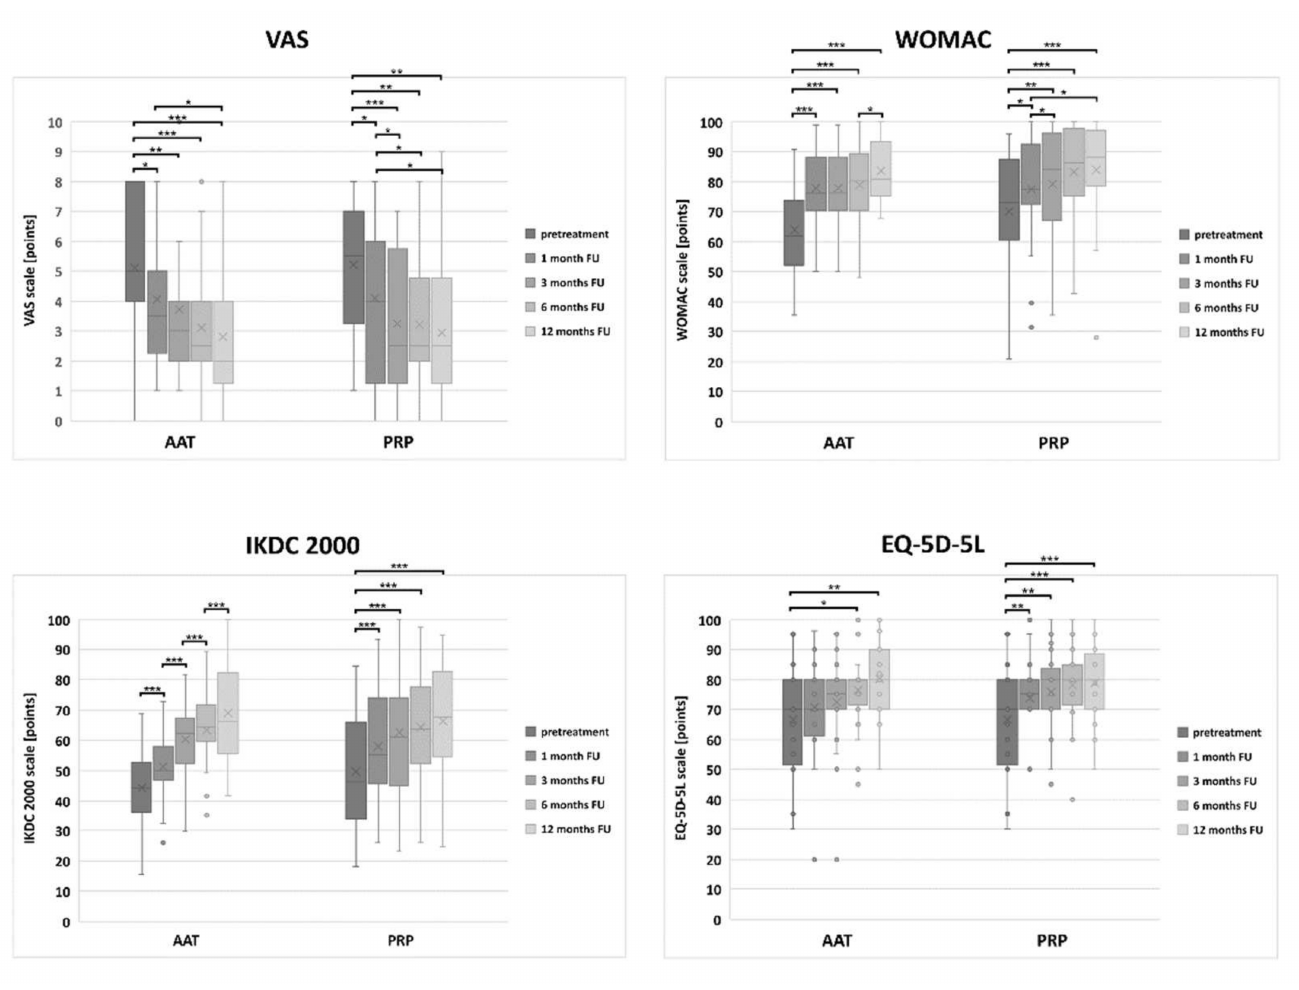
Figure 3. The distribution of the VAS, WOMAC, IKDC 2000 and EQ-5D-5L scores values in the PRP and the AAT treatment groups. Central lines represent the medians, boxes indicate the range from 25th to 75th percentile, whiskers extend 1.5 times above the interquartile range and outliers are represented as dots. The significance was designated as * p < 0.05, ** p < 0.01 and *** p <